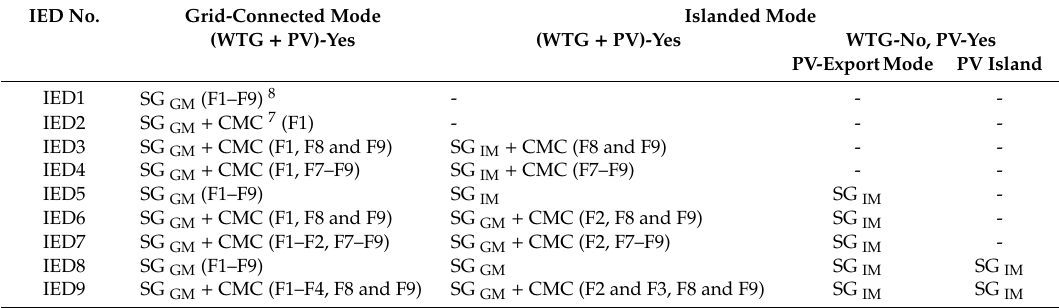
Table 5. The adaptivity of SG GM or SG IM settings and CMC 8 requirements at various IEDs (Figure 2) during di ff erent faults in grid-connected and islanded mode scenarios with predefined fixed fault current contributions from